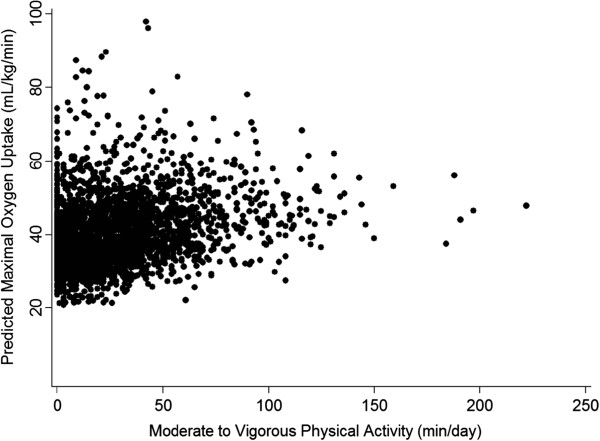
Relationship between average minutes of daily MVPA and cardiorespiratory fitness.